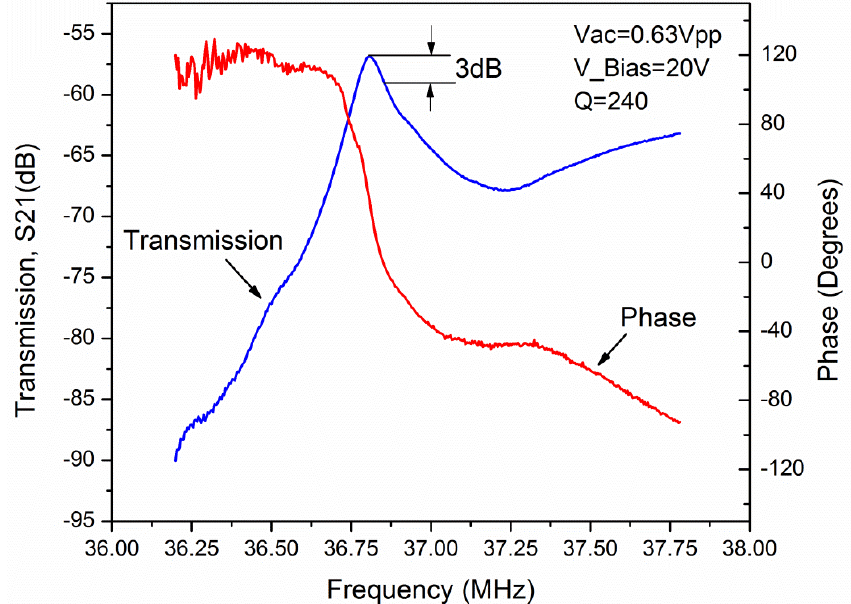
Figure 4. Measured S21 transmission of 36.8 MHz square resonator under DI water droplet (top surface contacted with water).